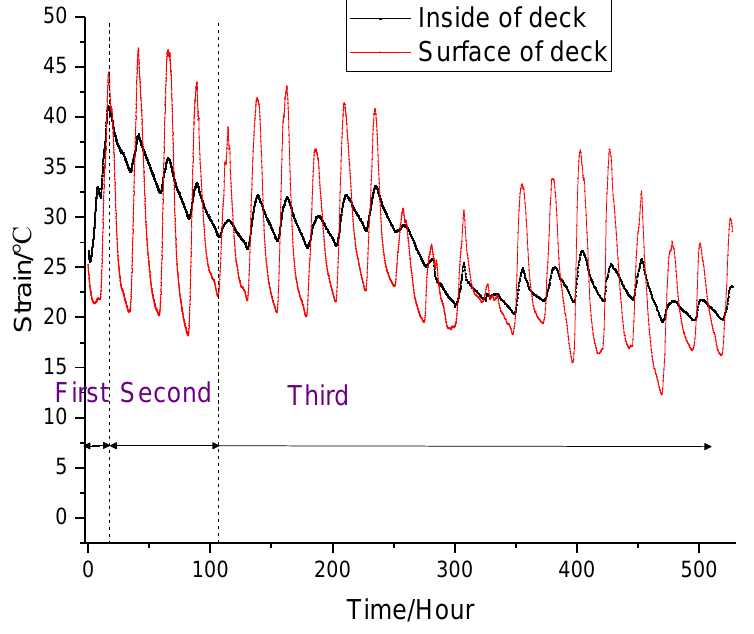
Figure 7. Curve of temperature variation.